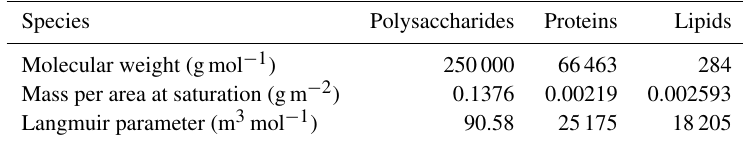
Table 3. Molecular weights, mass at saturation, and Langmuir parameters of the three ocean macromolecules.